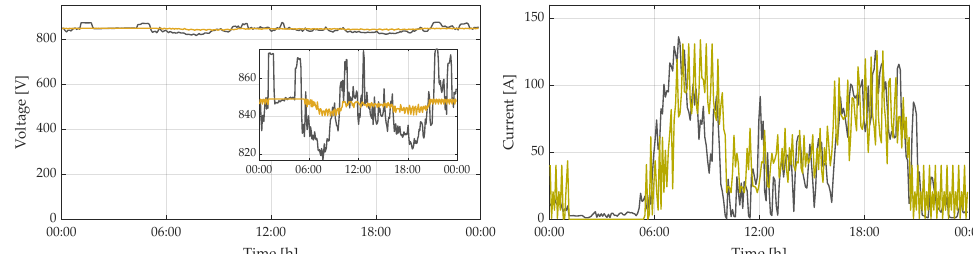
Figure 11. Measurement (black) and simulations (yellow) of voltage ( left ) and current ( right ) in TS T-T in an average window of 5 min. The plots cover a 24-h simulation